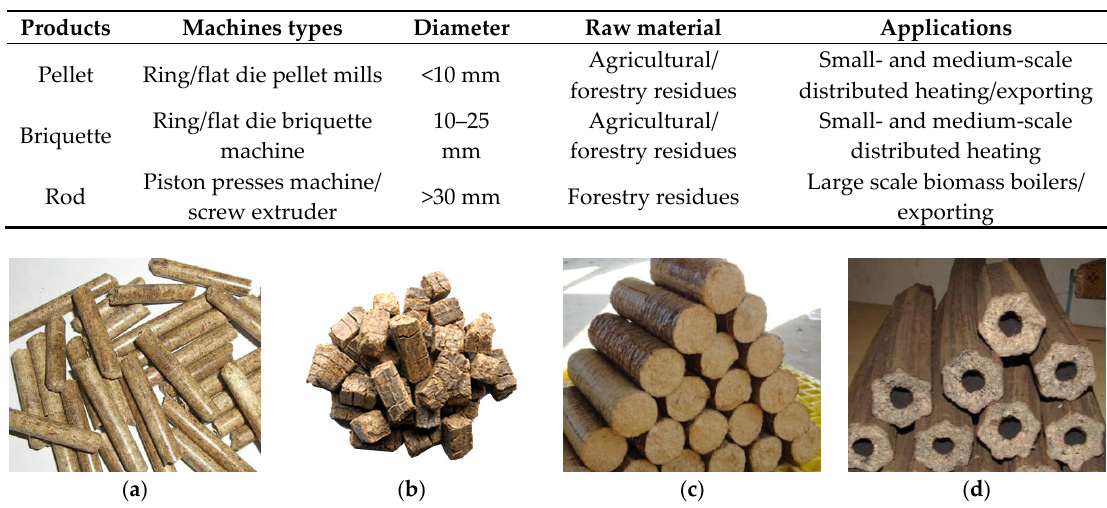
Table 1. Common biomass molded fuel (BMF) technologies in China.